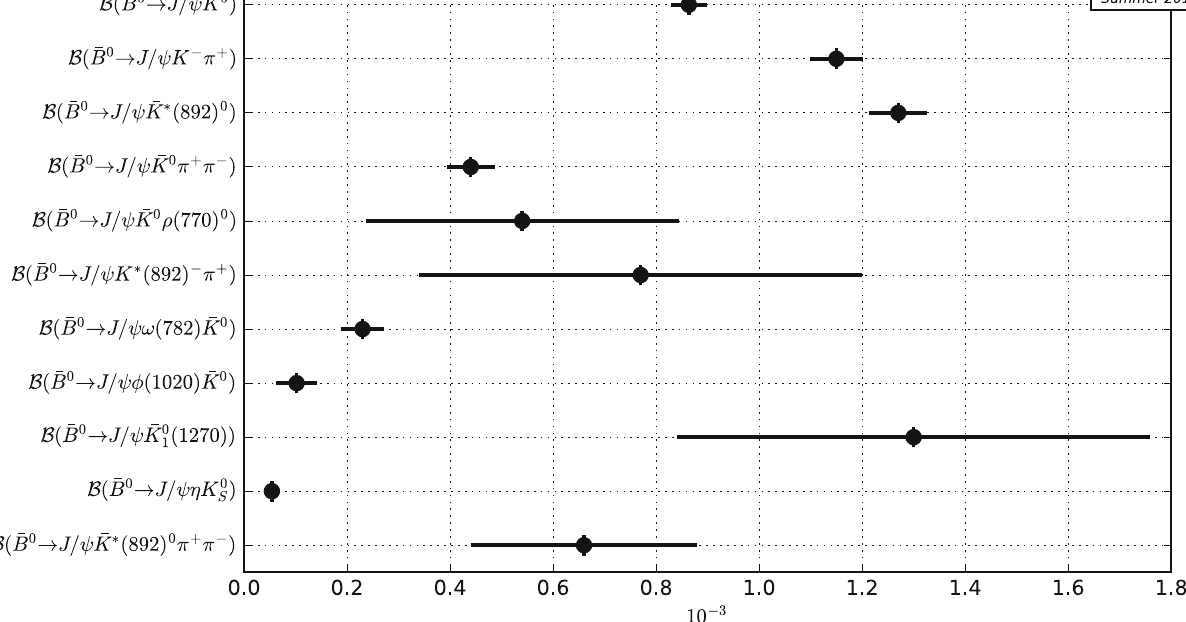
Fig. 90 Summary of the averages from Table 116